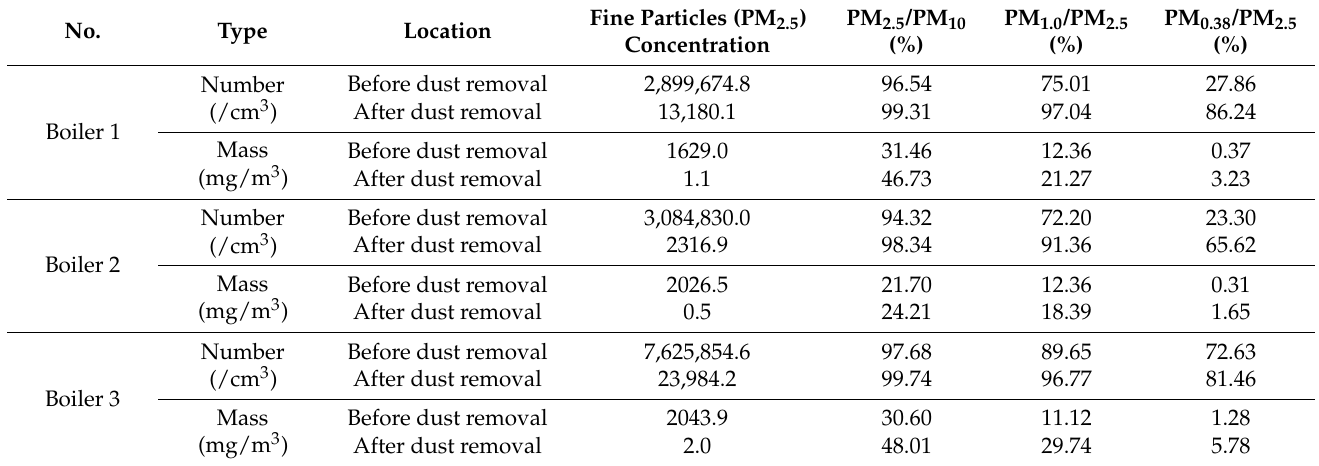
Table 5. Number/mass concentration of fine particle from three CFB boilers and the ratio of the concentration of different particle size